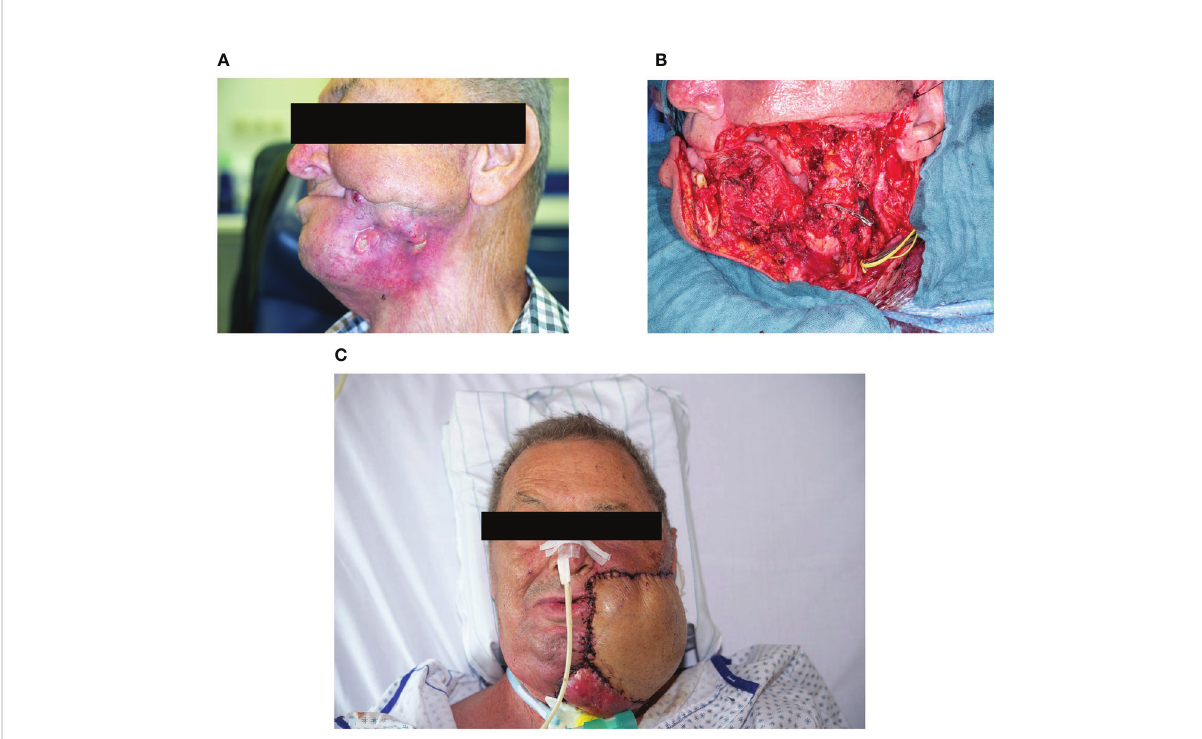
FIGURE 3 Case C (A) Abscess and multiple skin fi stulas on the left paramandibular side due to cutaneous metastasis under IT. Photo taken during tumor aftercare from the left-hand side. (B) Salvage surgery. Tumor resection with hemimandibulectomy of the left side and partial resection of the left buccal region/maxilla. (C) Reconstruction with two microvascular grafts. Microvascular double fl ap reconstruction with anterior lateral thigh and latissimus dorsi fl